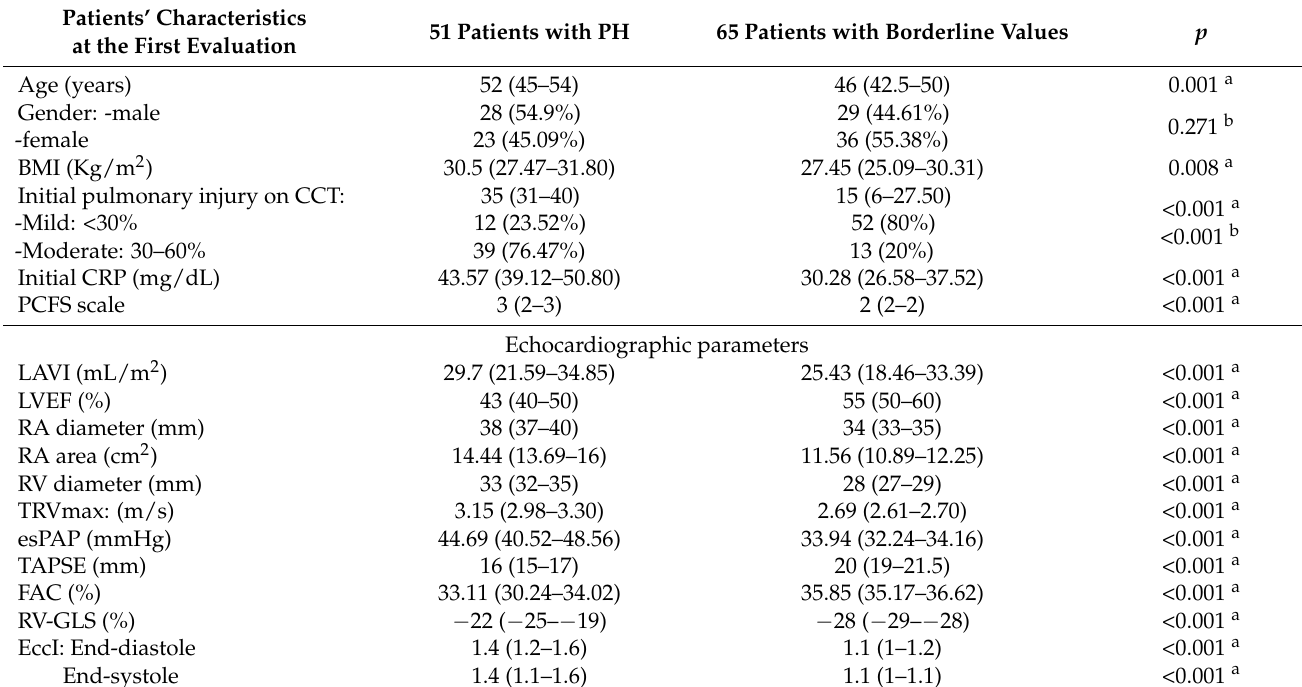
Table 1. Characteristics of the study